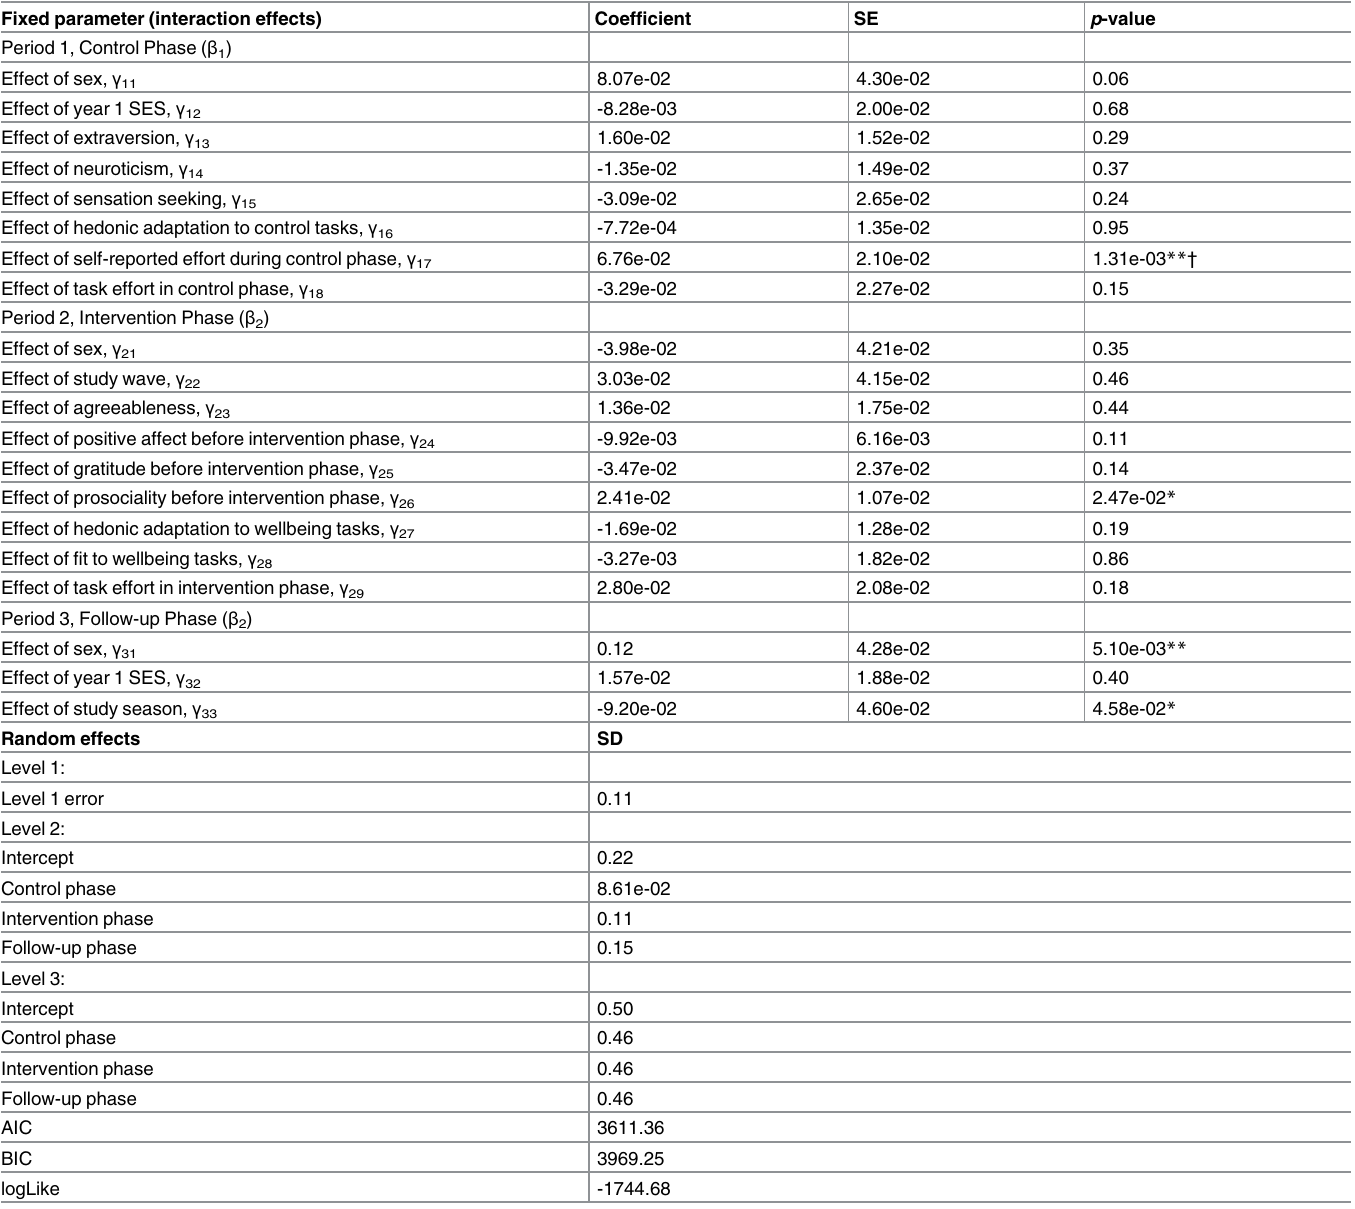
Table 2. Moderator model for wellbeing